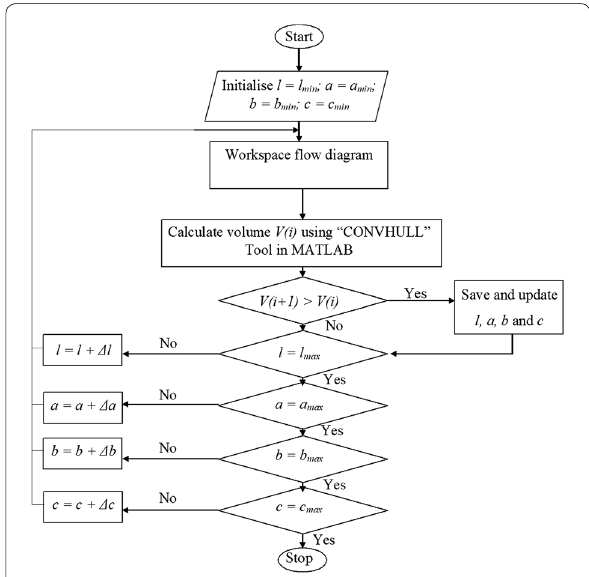
Figure 8 Flow diagram for dimensional synthesis based on the workspace